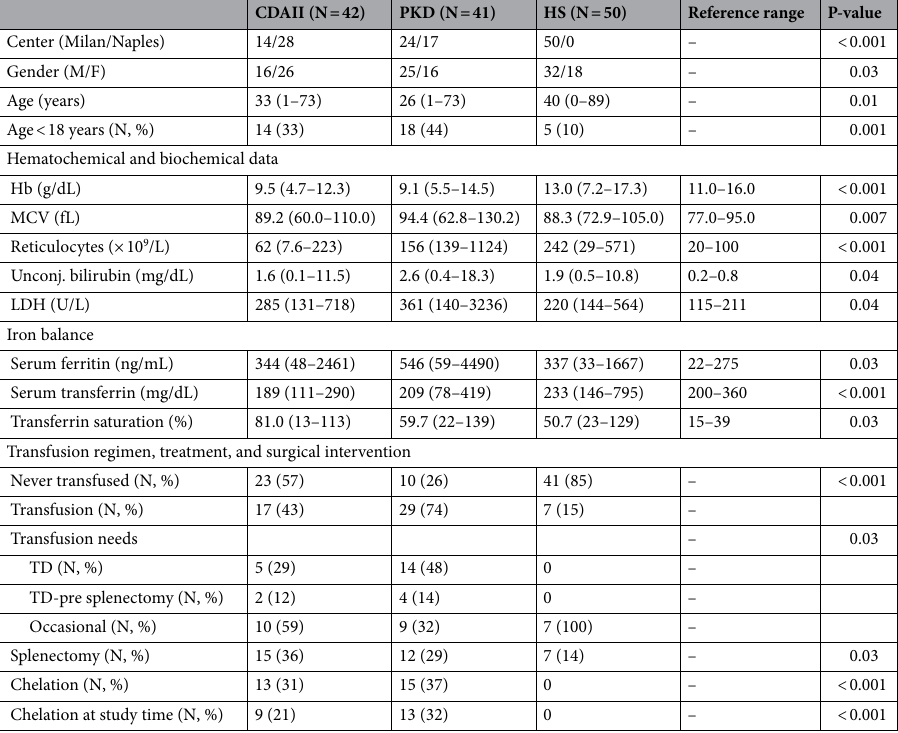
Table 1. Clinical and hematologic data of patients. Clinical information and laboratory data are referred at sampling. For quantitative variables data are presented as median (range). TD transfusion dependency. P-values from chi-squared (categorical variables) or Kruskal–Wallis (quantitative